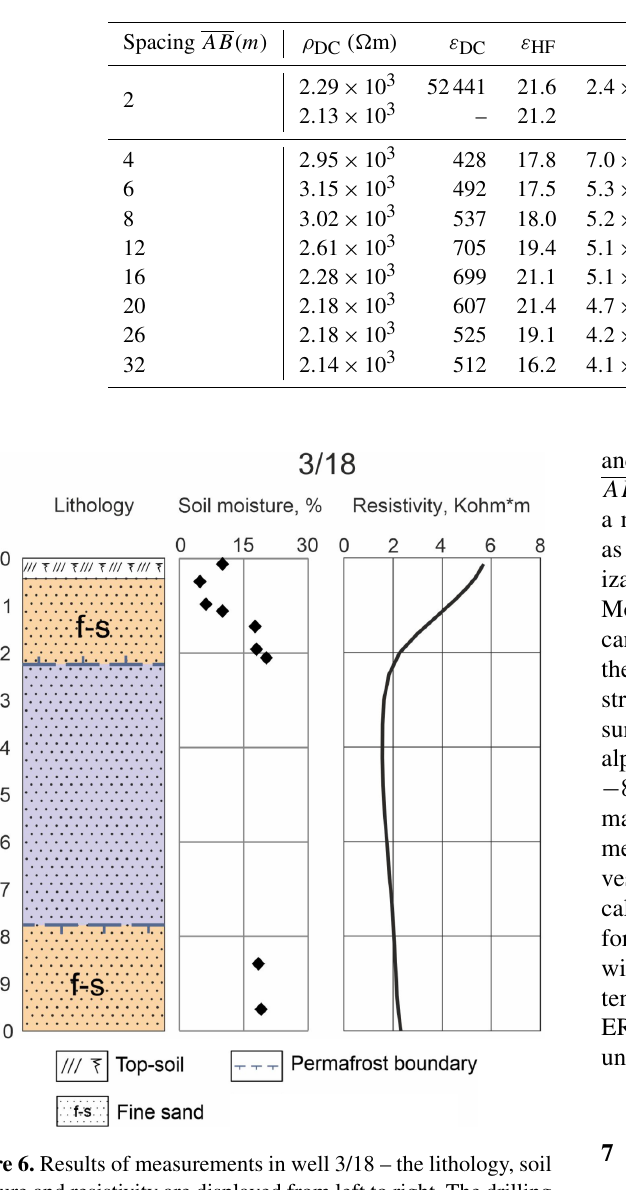
Table 1. Model parameters of the data fit for the different spacings of the sounding. The measured impedance spectra were fitted by the single Cole–Cole model (Eq. 1) by five parameters. Additionally, for the smallest spacing another data fit with constant electrical parameters over frequency was made. The data fit is quantified by the root mean squares.